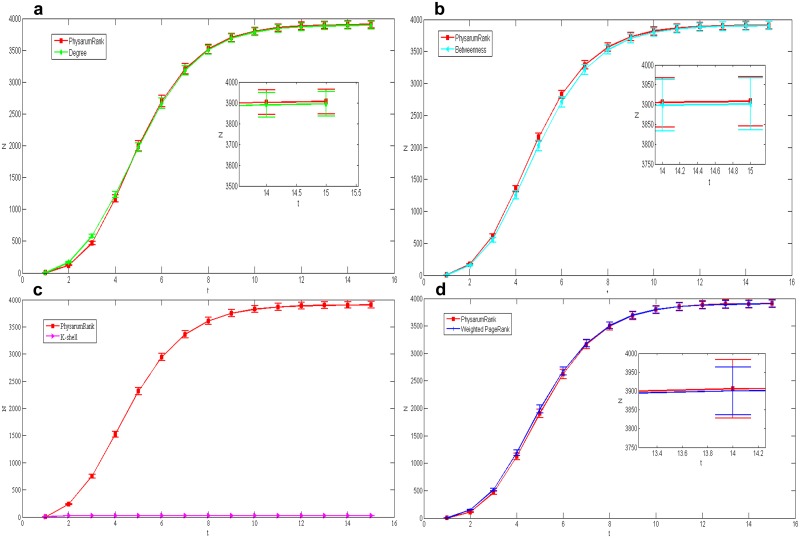
Comparison of epidemic spreading efficiency among different measures when L = 20, in collaborations network.Each result N is obtained by averaging over 100 implementations with α = 0.2 and β = 1. (a):PhysarumSpreader vs Degree, n = 11. (b):PhysarumSpreader vs Betweenness, n = 16. (c):PhysarumSpreader vs K-shell, n = 20. (d):PhysarumSpreader vs Weighted PageRank, n = 10.